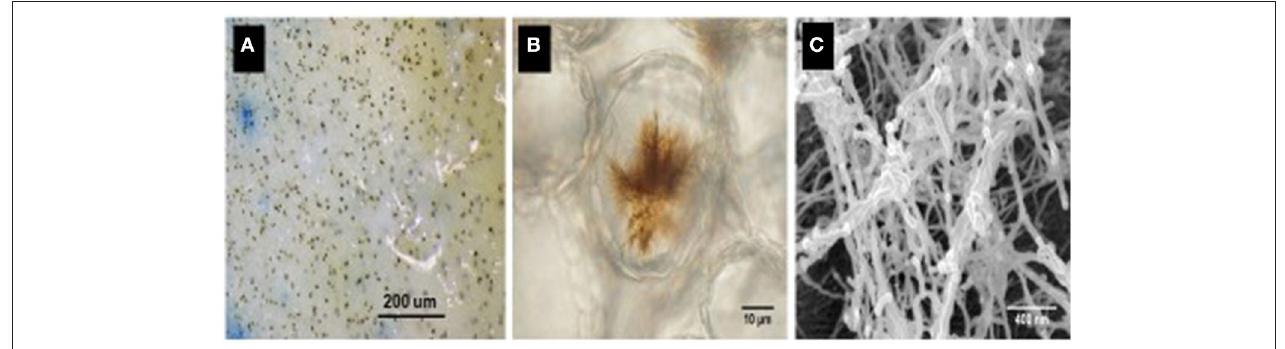
FIGURE 2 | Brown infection structures produced by Neopseudocercosporella capsellae on a highly susceptible Brassica juncea cotyledon, 24h post-inoculation as seen under a light microscope (decolorized by immersing in acetic acid: ethanol: water (2:2:1) solution at 25 ◦ C for 3–4 days) (A,B) . Scanning electron micrograph illustrating fine thread-like structures observed inside the host within the cortical tissue of an infected cotyledon (C) .